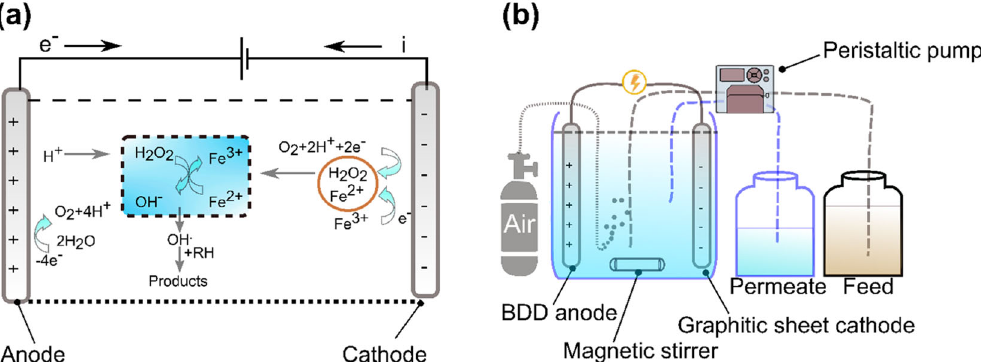
Fig. 1 Electro-Fenton process. ( a ) Illustration of reaction mechanism in electro-Fenton process (inspired from 308 ), and ( b ) The schematic of a continuous electro-Fenton process (inspired from 296